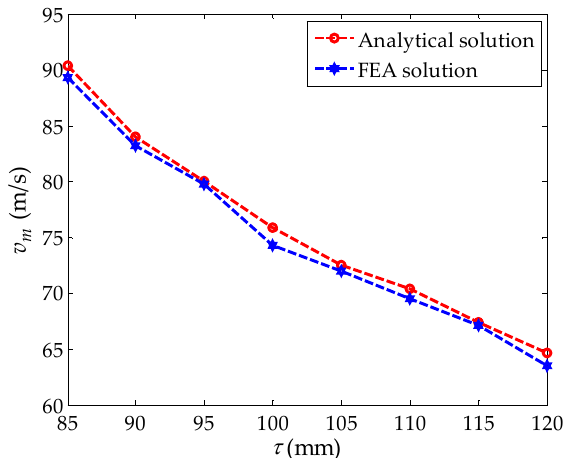
Figure 10. The critical speed varying with the pole pitch.